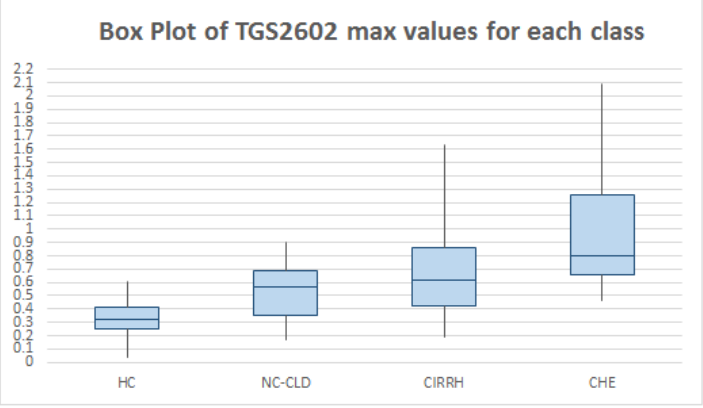
Figure 3. Box plot representing the median values, first quartile and 3rd quartile of TGS2602 maximum outputs relative to HC, NC-CLD, CIRRH and